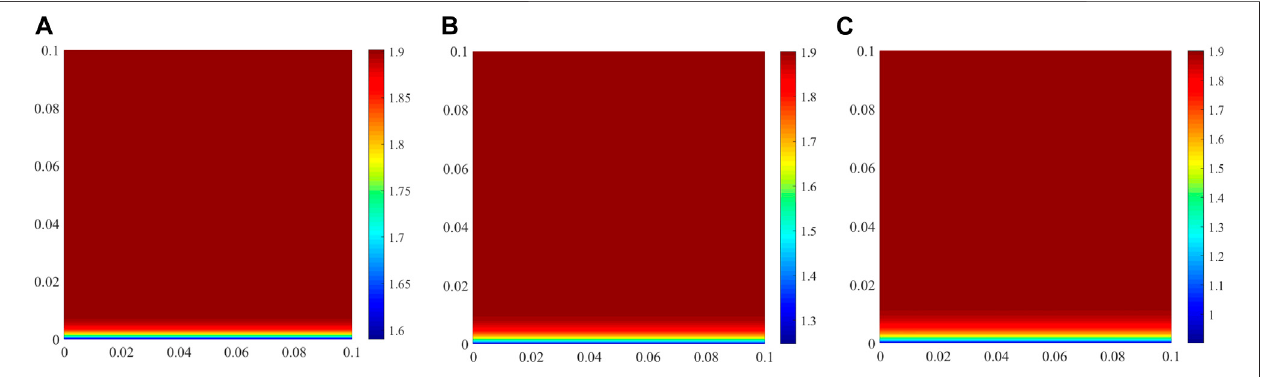
FIGURE 9 | Amount of CH in CAC at different exposure times (unit: mol/L of concrete). (A) 30 days, (B) 180 days, (C) 360 days.